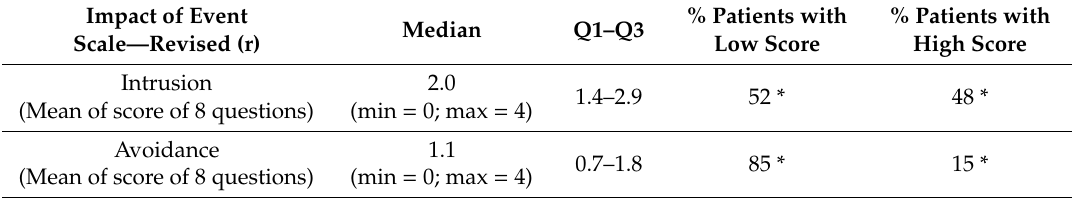
Table 3. Emotional and stressful condition of the interviewees (IES-r